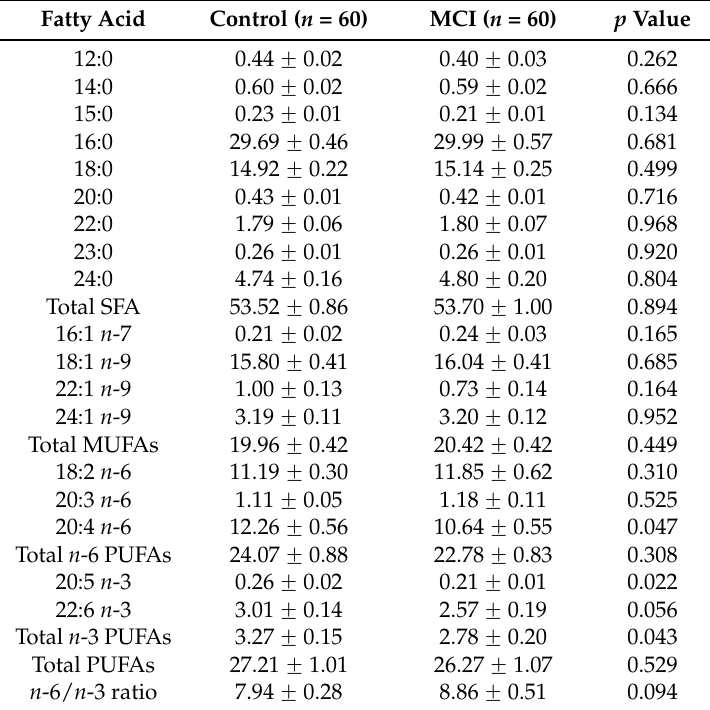
Table 3. Erythrocyte fatty acid profile of control and MCI subjects ( w / w ,